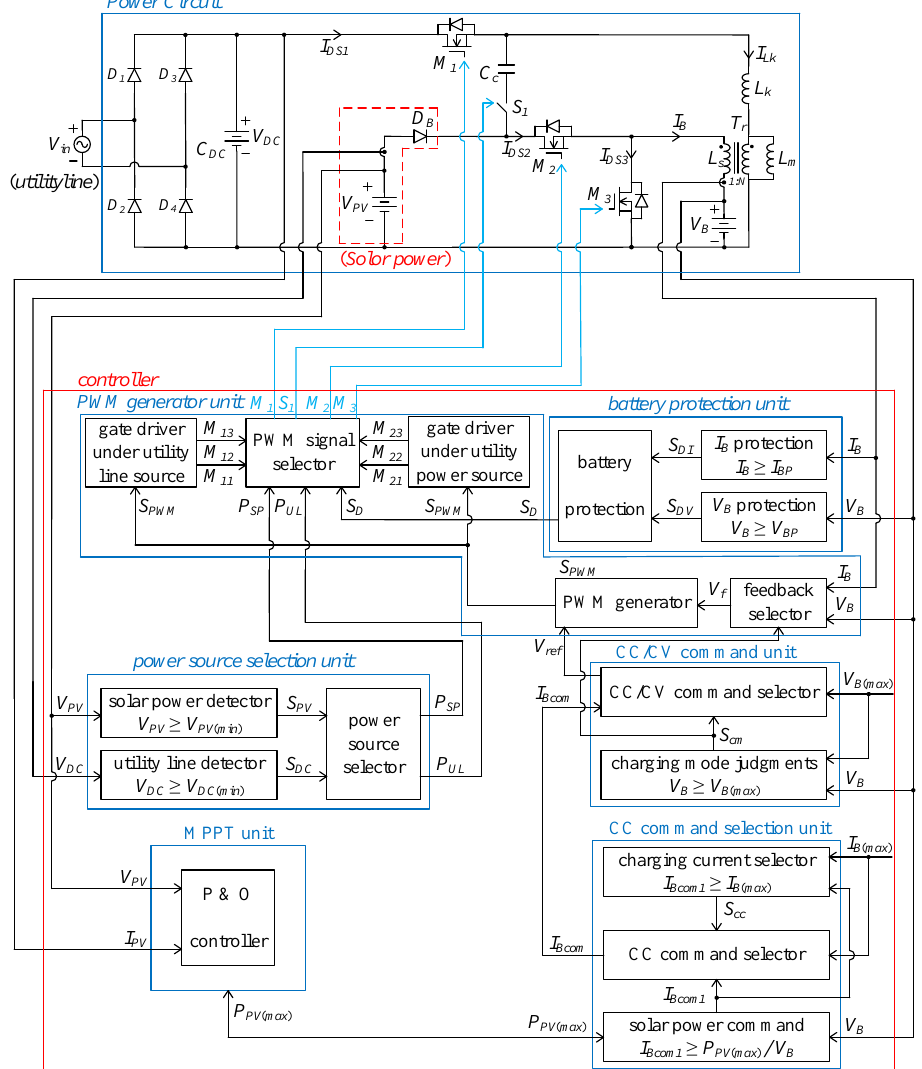
Figure 13. Block diagram of controller for the proposed hybrid converter.